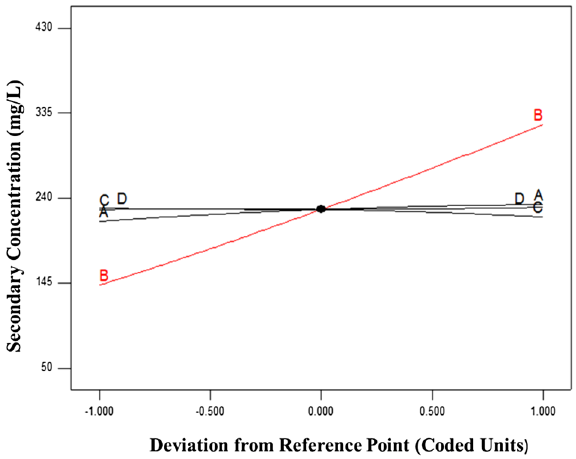
Figure 9. Perturbation curves displaying the influence of process variables on pH ( A ), C 0 Cu2+ ( B ), T ( C ) and t ( D ) on the secondary concentration of Cu 2+